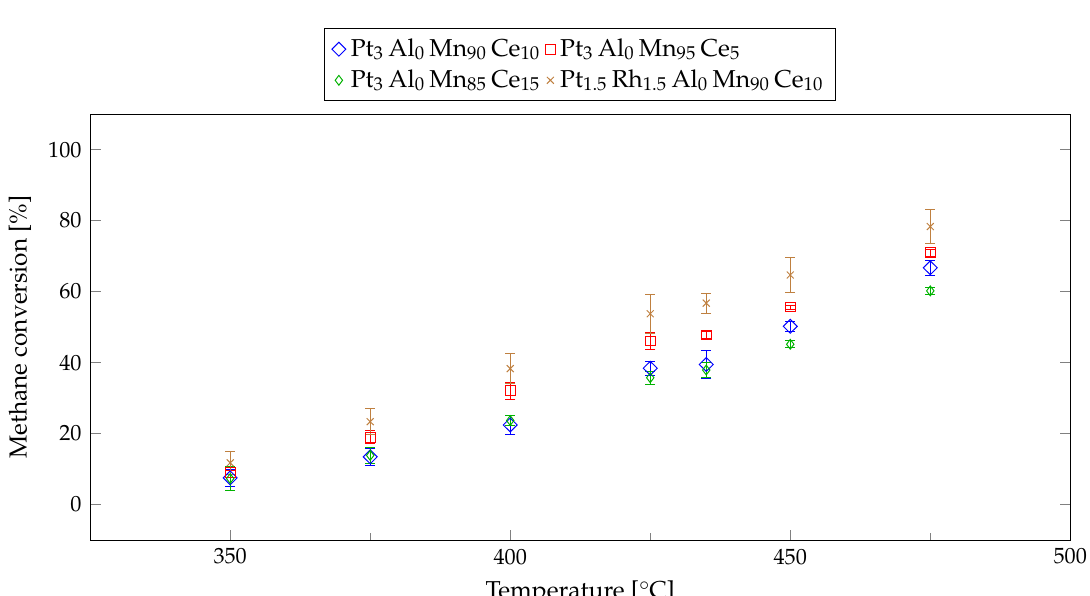
Figure 16. Methane conversion at different temperatures of samples containing Pt 3 or Pt 1.5 Rh 1.5 with a composition in the area around Al 0 Mn 90 Ce 10 . 12.5vol.% H 2 O, 12.5vol.% CO 2 , 9.0vol.% O 2 , 0.25vol.% CH 4 , 0.055vol.% CO, 0.012vol.% NO, 0.004vol.% NO 2 , 0.001vol.% SO 2 , balance He, WHSV = 36,000mL/ ( gh ) . Error bars represent standard deviation ( n = 3) as given by Equation 2.